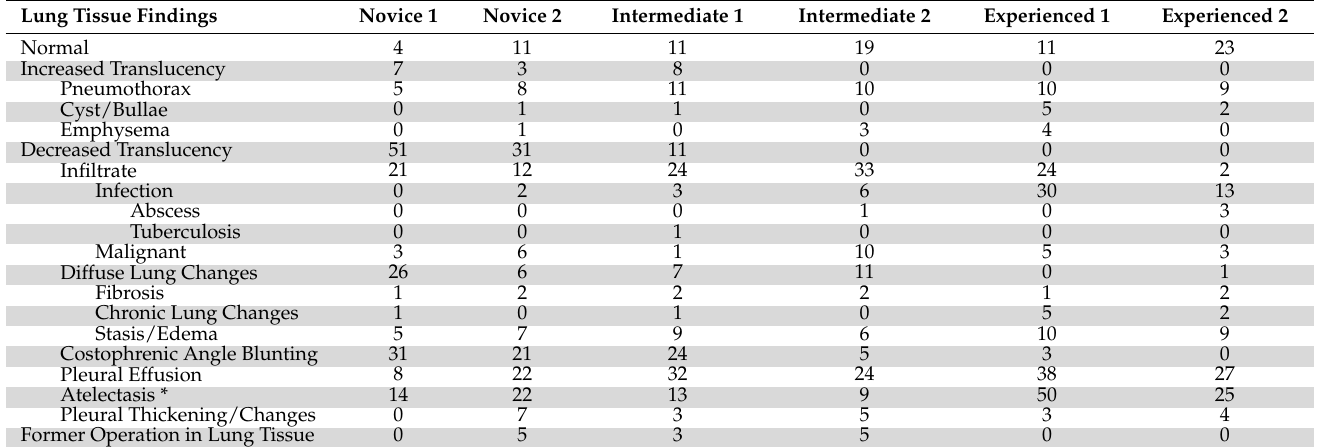
Table 1. Frequency table for each individual participating radiologist. The total number of cases out of 100 CXRs that had been annotated with that specific label by a radiologist. * Does not differentiate between linear and segmental atelectasis, which could explain the difference in frequency of